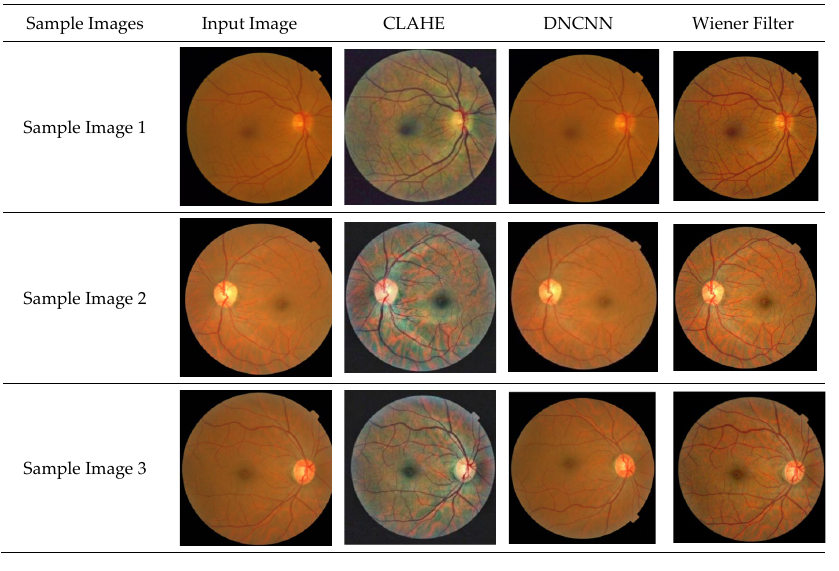
Appl. Sci. 2023 , 13 , x FOR PEER REVIEW Figure 6. Output of image enhancement in retinal images. Figure 6. Output of image enhancement in retinal images.